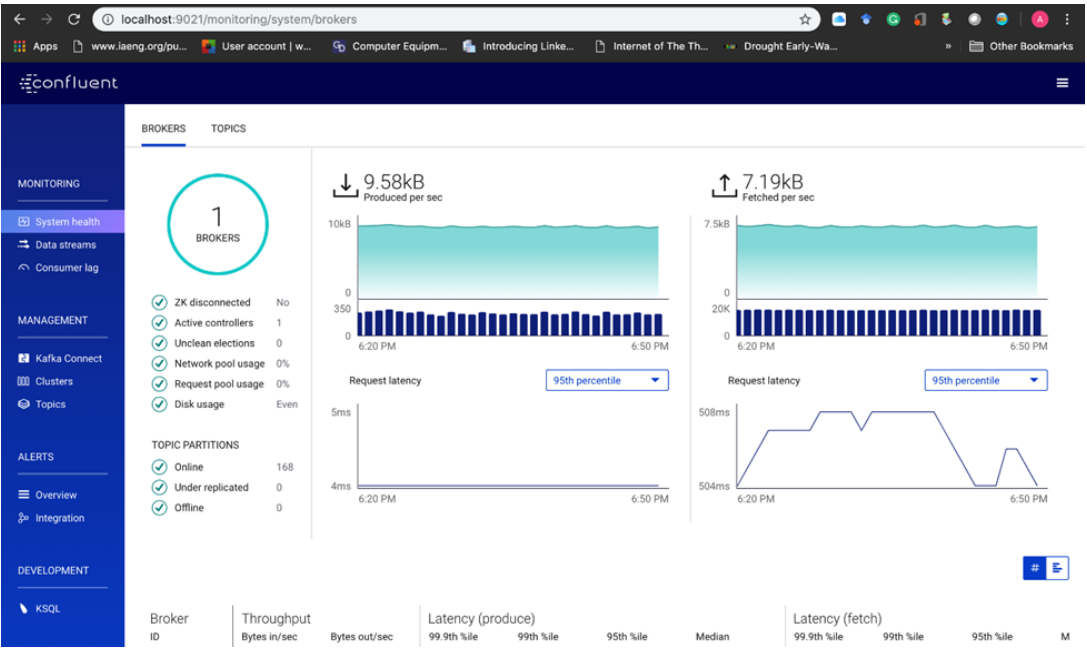
Figure 10. The Confluent Enterprise Streaming Framework [16].